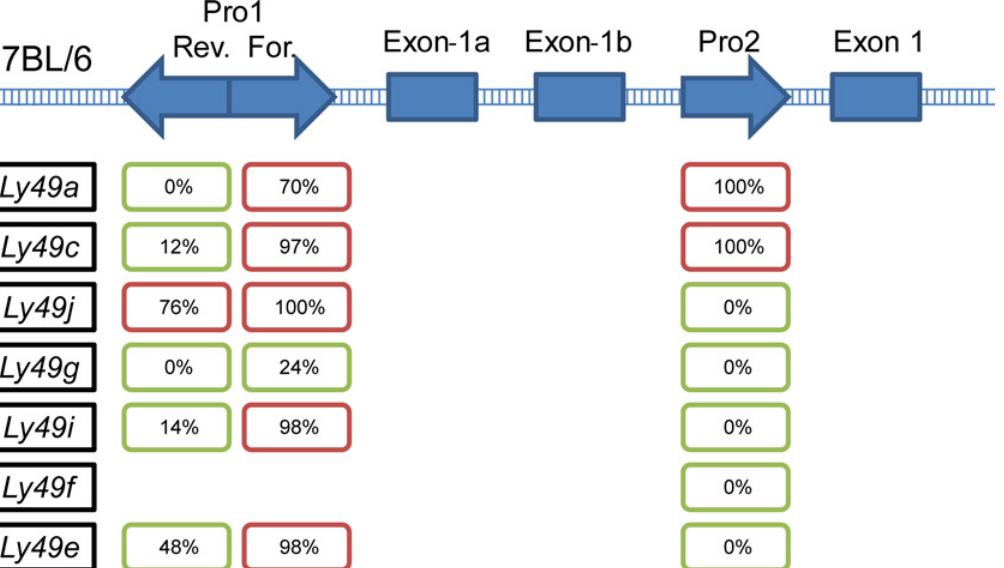
Fig 1. Predicted nucleosome hindrance at Ly49 forward promoter 1. Probable nucleosome position across the Ly49 gene family in the C57BL/6 mouse was determined using a 4 th order Hidden Markov model, based on the genomic sequence affinity for nucleosome binding. For each Ly49 gene with an annotated Pro1 and/or Pro2 region, the proportion of bases covered by a nucleosome is indicated. Regions with over half the bases covered are coloured red, while regions with over half the bases exposed are coloured green.